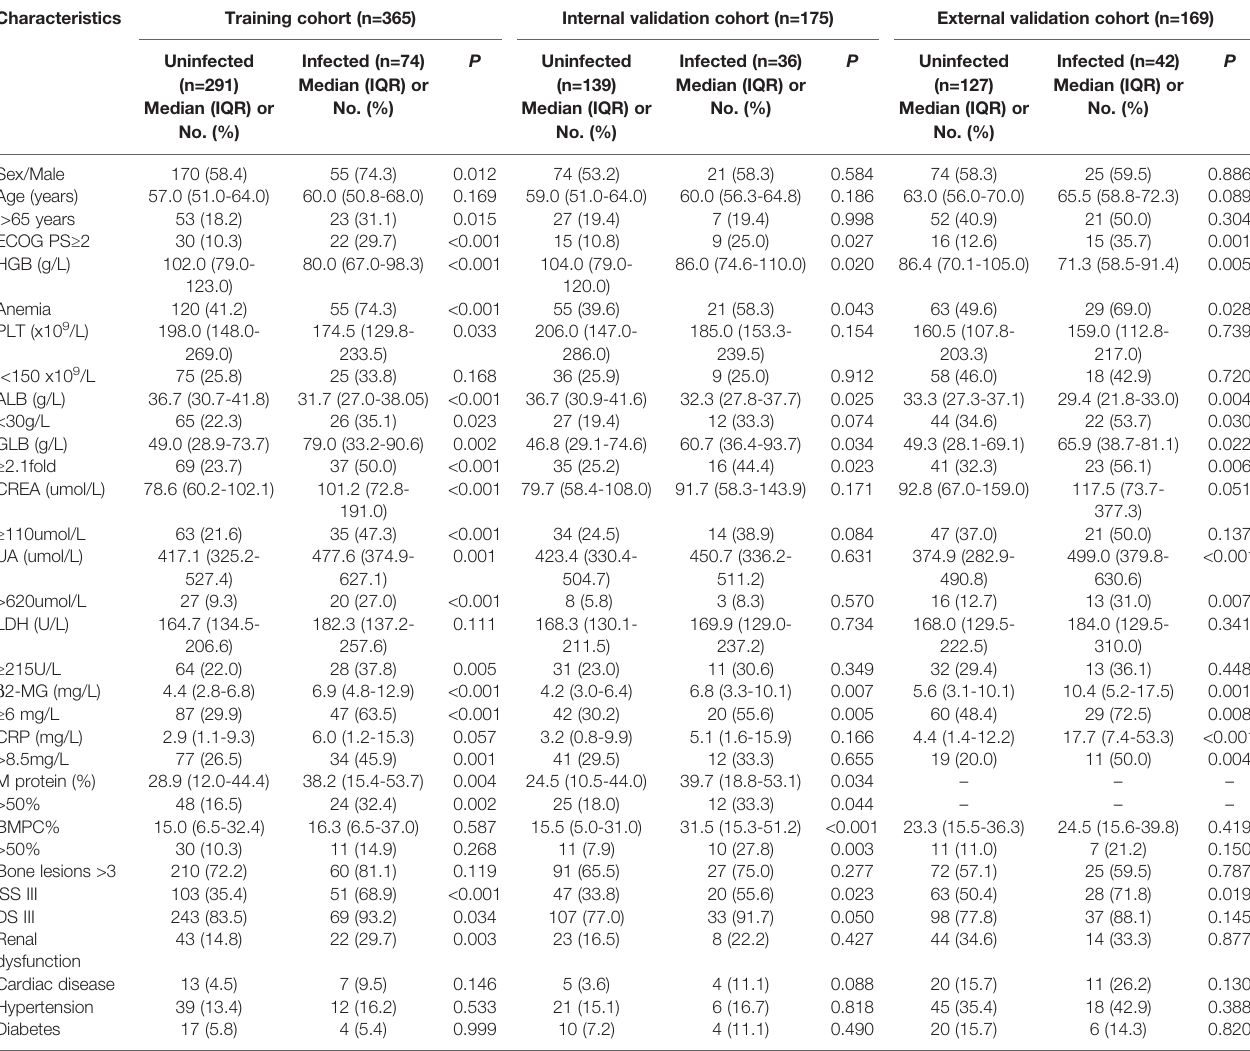
TABLE 2 | Distribution and comparisons of infected patients and uninfected patients in the fi rst 3 months in the training cohort, internal validation cohort and external validation cohort.